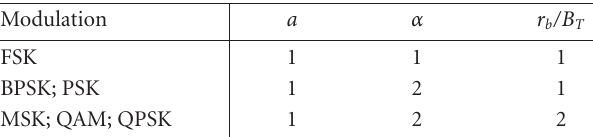
Table 2: Parameters a, α , and the spectral e ffi ciency r b /B T for dif- ferent